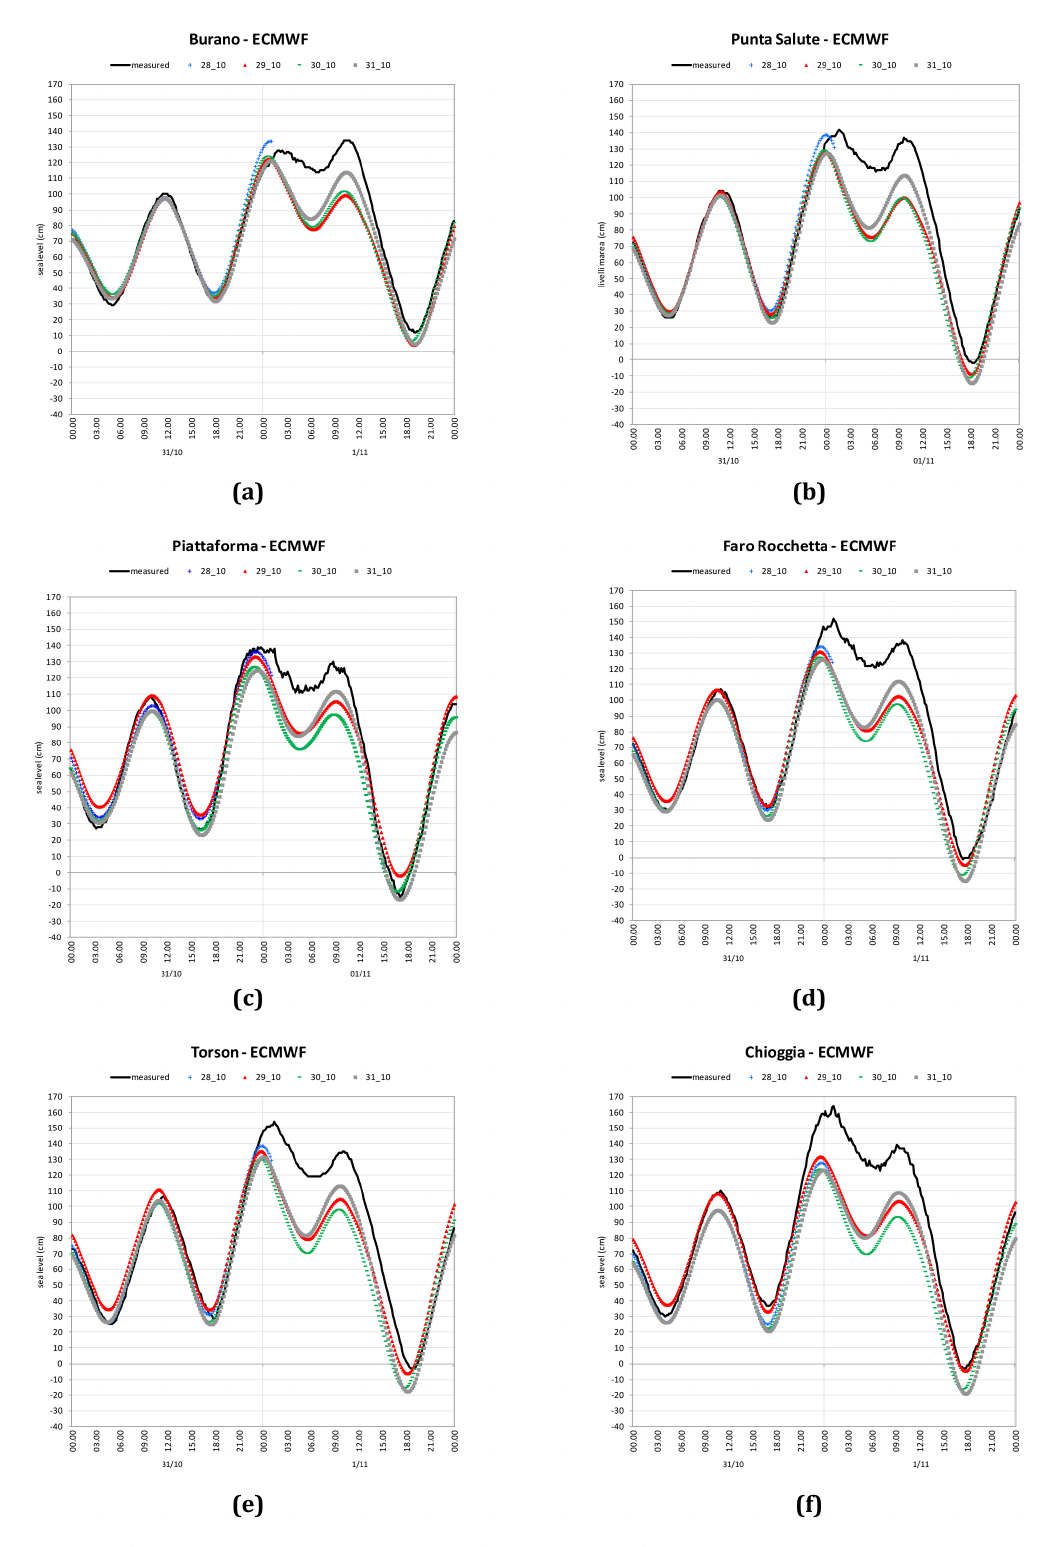
Figure 15. Comparison for IOP18 between the ECMWF IFS-forced SHYFEM forecasts and the sea level observations registered at the six considered tide-gauge instruments, with meteorological forecast forcing from 28 to 31 October: (a) Burano; (b) Punta della Salute; (c) Piattaforma; (d) Faro Rocchetta; (e) Torson; (f)